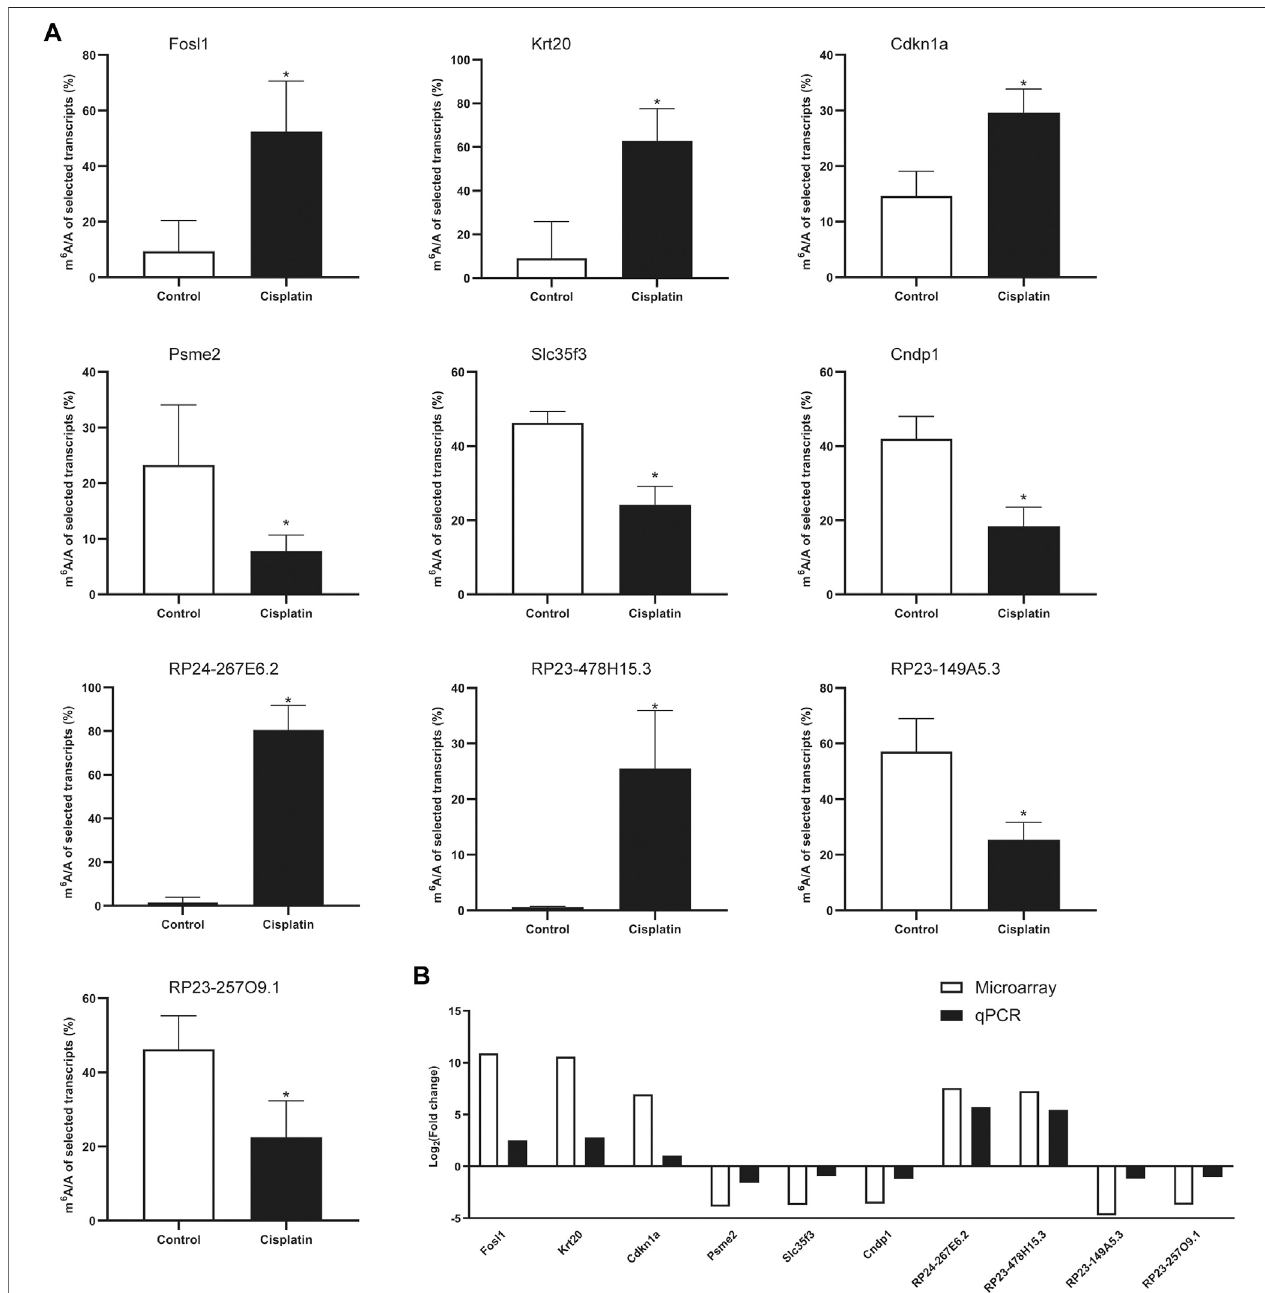
FIGURE 5 | MeRIP-qPCR veri fi cation of differentially methylated RNA expression. (A) The m 6 A enrichment of selected mRNAs and lncRNAs was detected by the MeRIP-qPCR method. * p < 0.05, vs. control group, n (cid:1) 4 per group. (B) The comparison between microarray data and MeRIP-qPCR results.